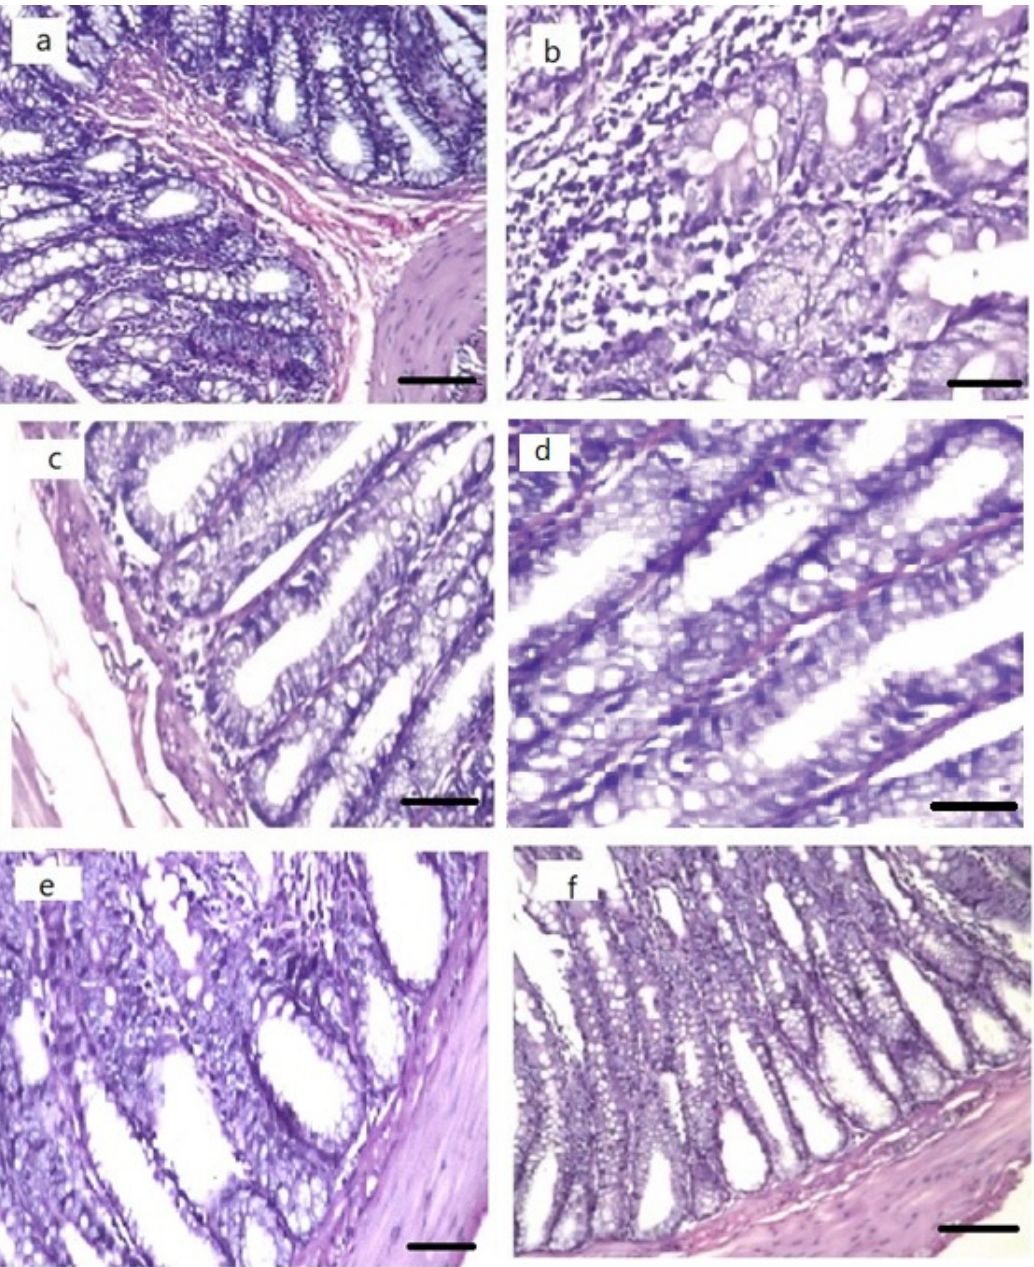
Figure 14. Histopathological changes of colon tissues: ( a , b ) colon tissues of control animals showing normal colon tissue with no histopathological alteration (H&E staining; scale bar, 200 µ m), ( c , d ) colon tissues of diseased animals showing focal ulceration in the lining mucosal epithelium associated with inflammatory cell infiltration in the underlying lamina propria (H&E staining; scale bar, 200 µ m), ( e ) colon tissues of diseased animals treated with GFT suspen‑ sion showing focal inflammatory cell infiltration in the lamina propria (H&E staining; scale bar, 200 µ m), ( f ) colon tissues of infected animals treated with GFT‑CNPs showing enhancement and decrease in the focal inflammatory cell infiltration in the lamina propria (H&E staining; scale bar, 200 µ